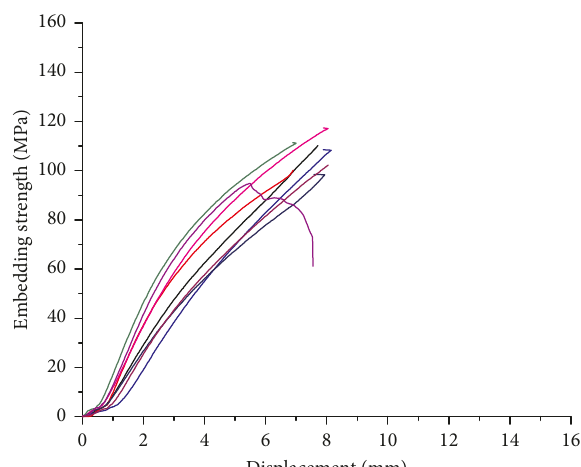
Figure 11: Strength-displacement curve of group H5.